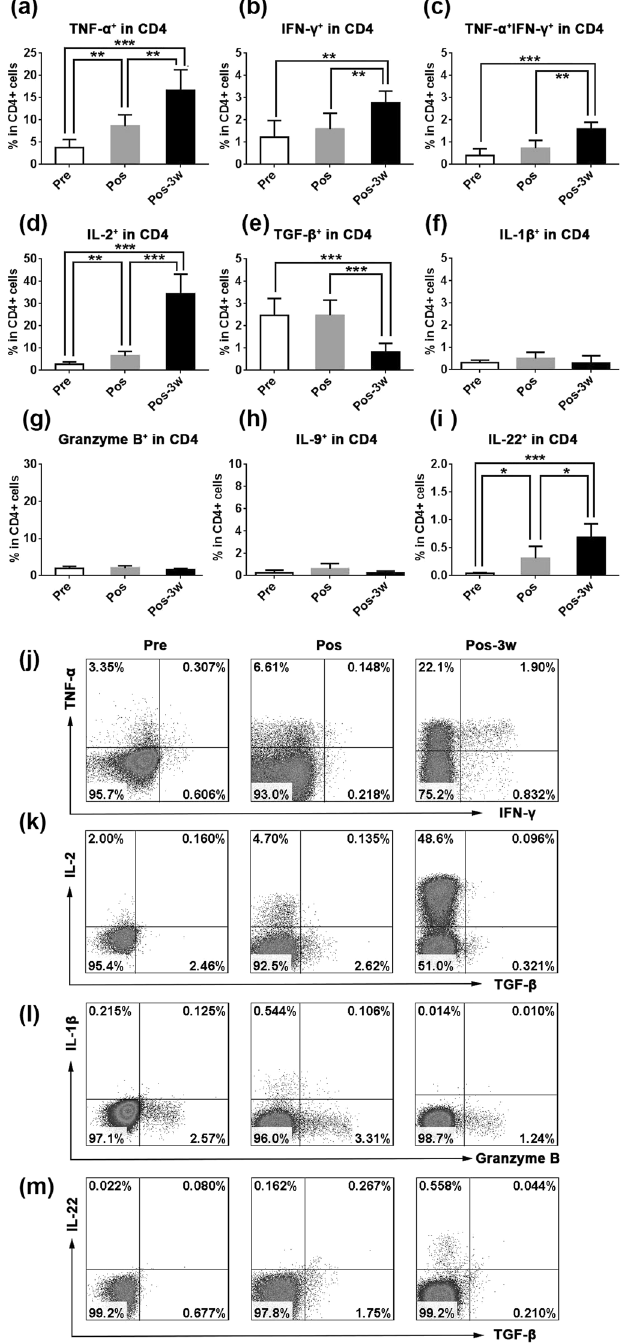
Figure 3. Cytokine secretion by peripheral CD4 + T cells after treatment with HSRT. PBMCs were activated using a leukocyte activation cocktail for 6 h, and the cells were then collected and labeled with IFN- γ ( j ), TNF- α ( j ), IL-2 (k), TGF- β ( k ), IL-1 β ( l ), granzyme B ( l ), or IL-22 ( m ). The mean values of the percentage of cells that were TNF α + CD4 + T cells in CD4 + T cells ( a ), IFN γ + CD4 + T cells in CD4 + T cells ( b ), TNF α + IFN γ + CD4 + T cells in CD4 + T cells ( c ), IL-2 + CD4 + T cells in CD4 + T cells ( d ), TGF- β + CD4 + T cells in CD4 + T cells ( e ), IL-1 β + CD4 + T cells in CD4 + T cells ( f ), granzyme B + CD4 + T cells in CD4 + T cells ( g ), IL-9 + CD4 + T cells in CD4 + T cells ( h ), and IL-22 + CD4 + T cells in CD4 + T cells ( i ) were analyzed at the indicated times. The panel j–m showed the representative result from one patient. The data are shown as the mean values ± SEM (n = 6). Statistics were derived using ANOVA with Bonferroni’s post-test. * p < 0.0167, ** p < 0.01; *** p < in Fig. 3d, CD4 + T cells expressed a high level of IL-2 on the day after HSRT (P = 0.0021), and the number of these cells was 20-fold higher after HSRT than was observed in untreated self-controls (P < 0.0001). Importantly, the level of the inhibitory cytokine TGF- β , which is expressed by CD4 + T cells, was decreased at 3 weeks after